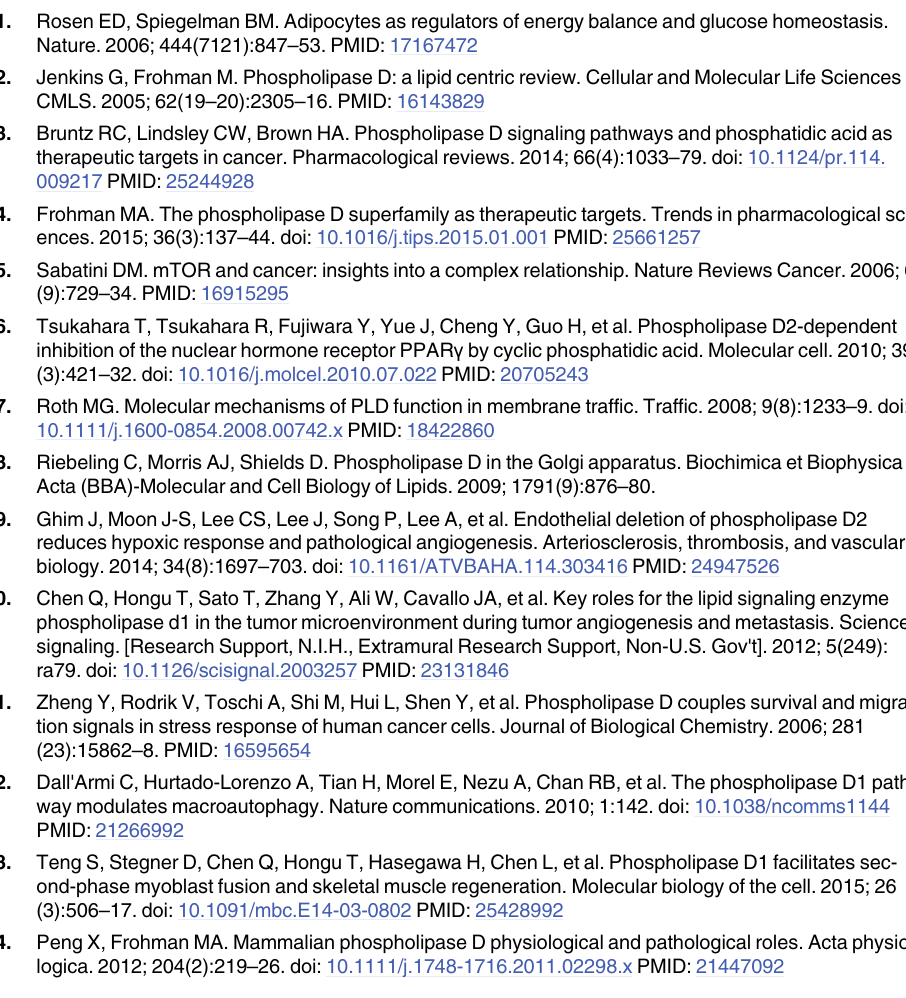
S1 Table. Primer list for the qPCR